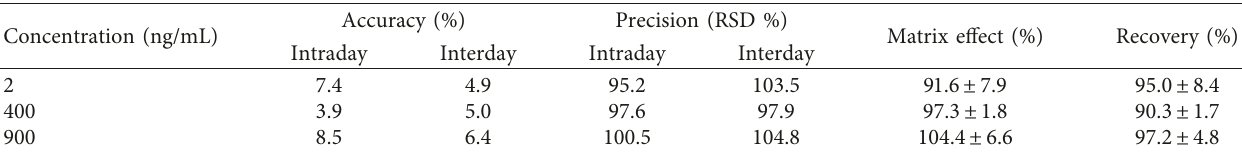
Table 1: Accuracy, precision, matrix effect, and recovery of jervine in rat